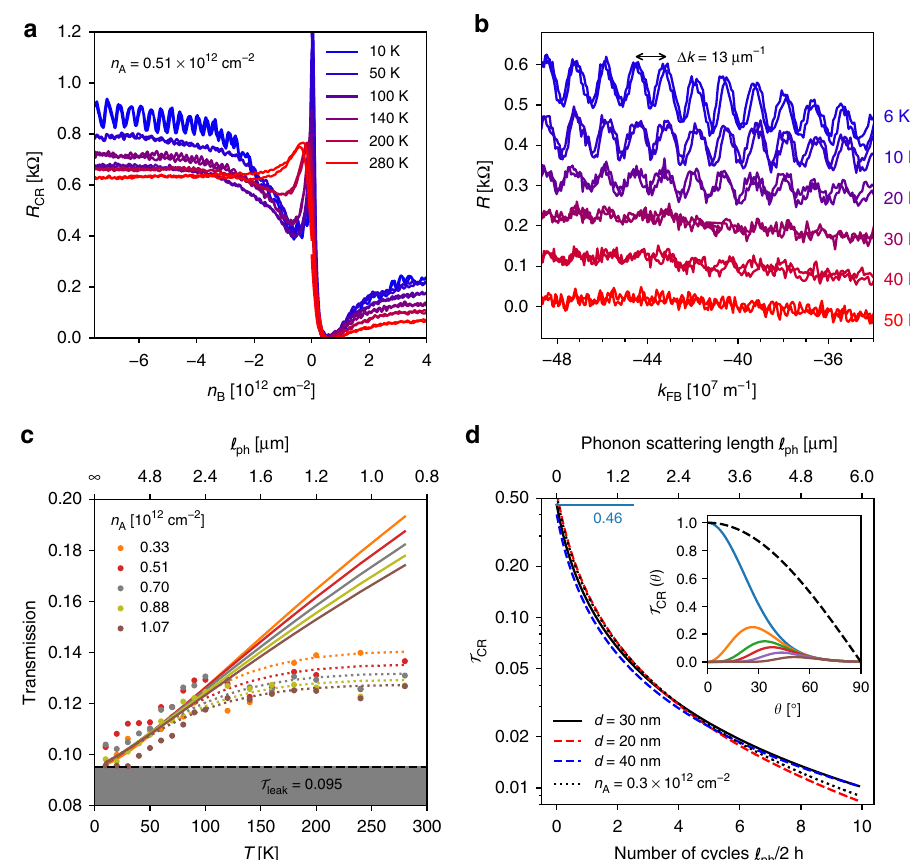
Fig. 3 Temperature dependence of the corner-re fl ector transmission: coherence, phonon scattering and saturation. a Device resistance (quasi-DC) at various temperatures T = 10 … 280 K. The plateau resistance decreases as the temperature increases. b At low temperatures, Fabry – Pérot type oscillations ( Δ k = 1.3 × 10 7 m − 1 ) are observed in the resistance, they disappear at T ≈ 40 K. (Resistance offset for clarity.) c Plateau transmission as a function of temperature for various access doping values n A . Solid lines and dotted lines are calculated using Eq. (1) with d = 30 nm and d = 30 nm + 2.25 pm/K 2 × T 2 respectively. d Plateau transmission Eq. (1) as a function of the number of round-trips in the CR, compared to the transmission of a single p – n junction T ¼ 0 : 46 (light blue bar). We used a junction length of d = 30 nm and doping values n = 0.5 and n = − 5 × 10 12 cm − 2 (black line). Varying the A B np þ junction length (red and blue dashed lines) or the doping (black dotted line) only has a small effect on the overall shape of this curve. Inset: CR transmission as a function of incident angle, for various numbers of cycles. Blue line: transmission of a single n – p junction (zero cycles). Other color lines represent how the transmission is increasingly suppressed when increasing the number of round-trips (1, 2, 3, 5, 10). The transmission is weighted in Eq. (1) by the cos θ factor (black dashed